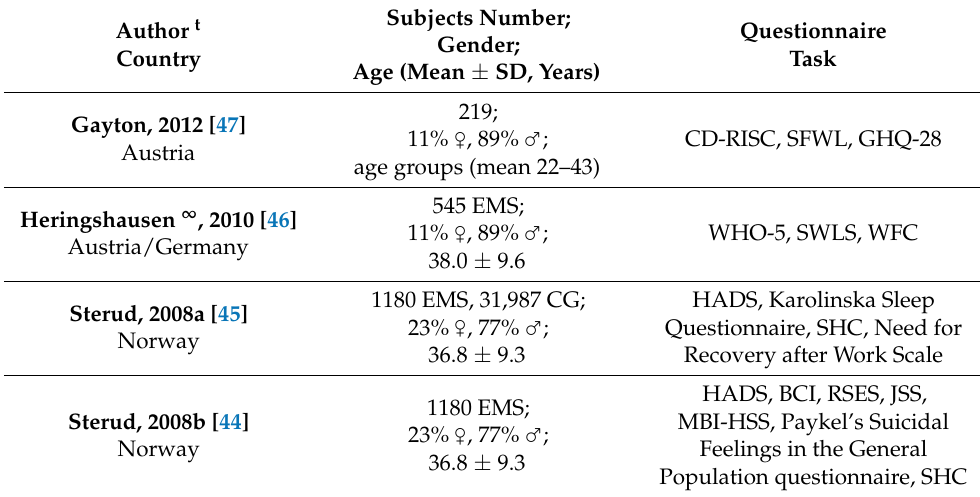
in Supplementary File